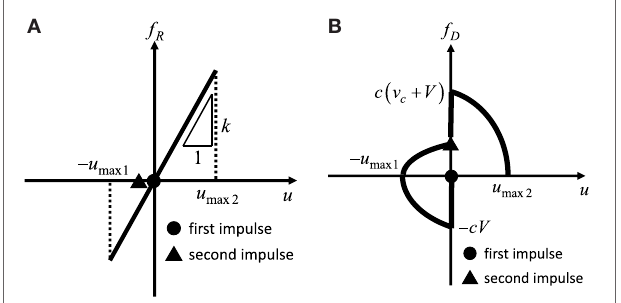
FIGURE 4 | Restoring force and damping force with respect to deformation in CASE 1 [ V / V y (cid:20) ( V / V y ) CASE1 ], (A) restoring force–deformation relation, (B) quadratic approximation of damping force–deformation